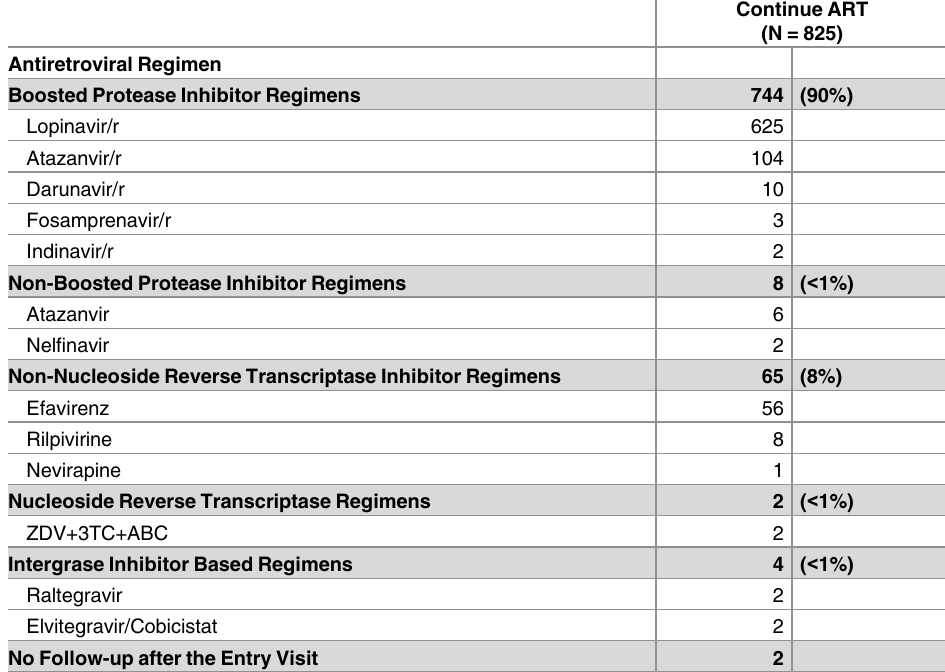
Table 2. ART use within 72 hours after randomization for the continue ART arm.